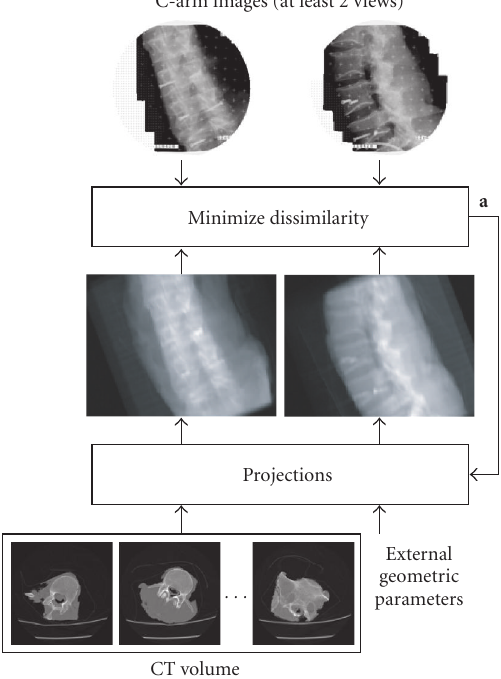
Figure 2: Algorithm for registering a 3D CT to C-arm